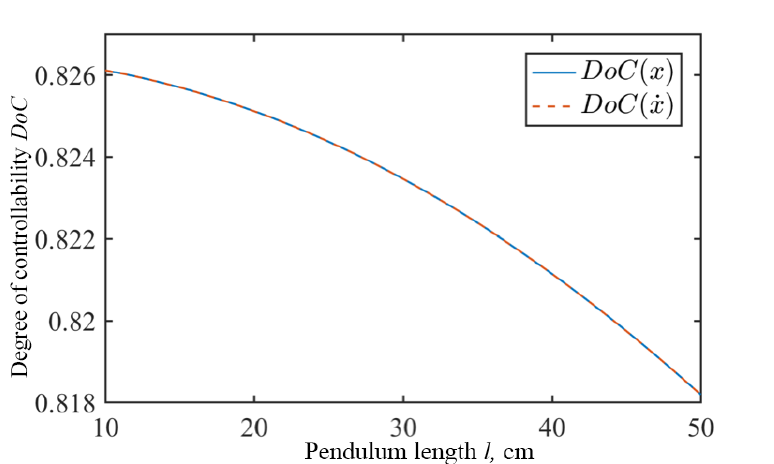
Figure 6. Change in the degree of controllability for x , ˙ x when increasing the length of the pendulum l .